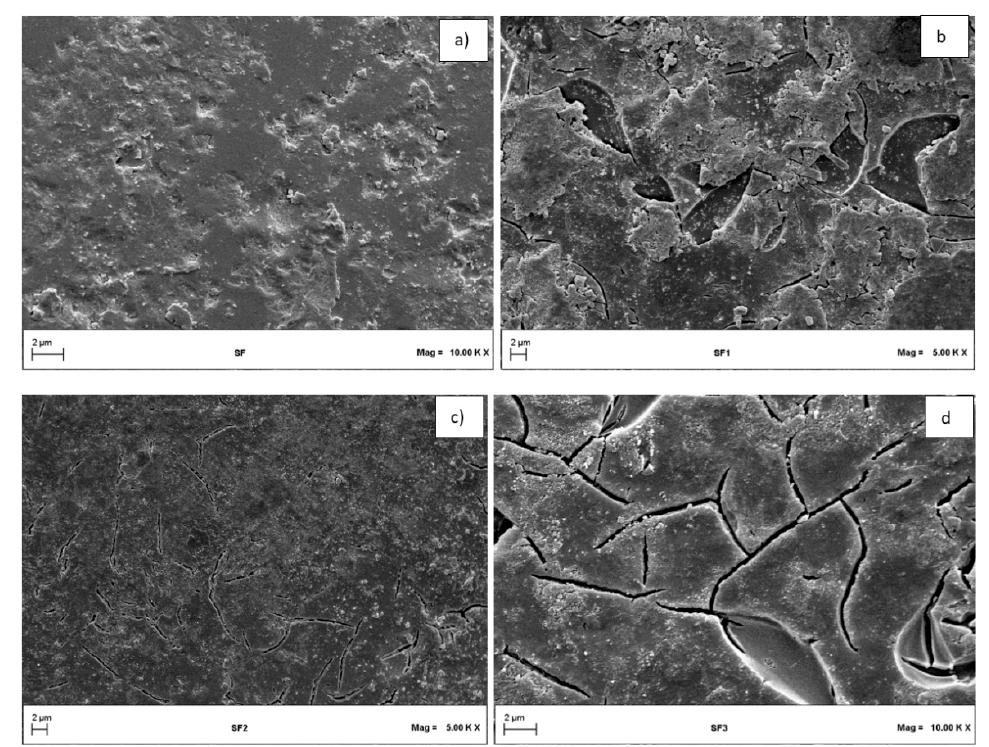
Figure 1. SEM images of SF ( a ), SF1 ( b ), SF2 ( c ) and SF3 ( d ) samples.